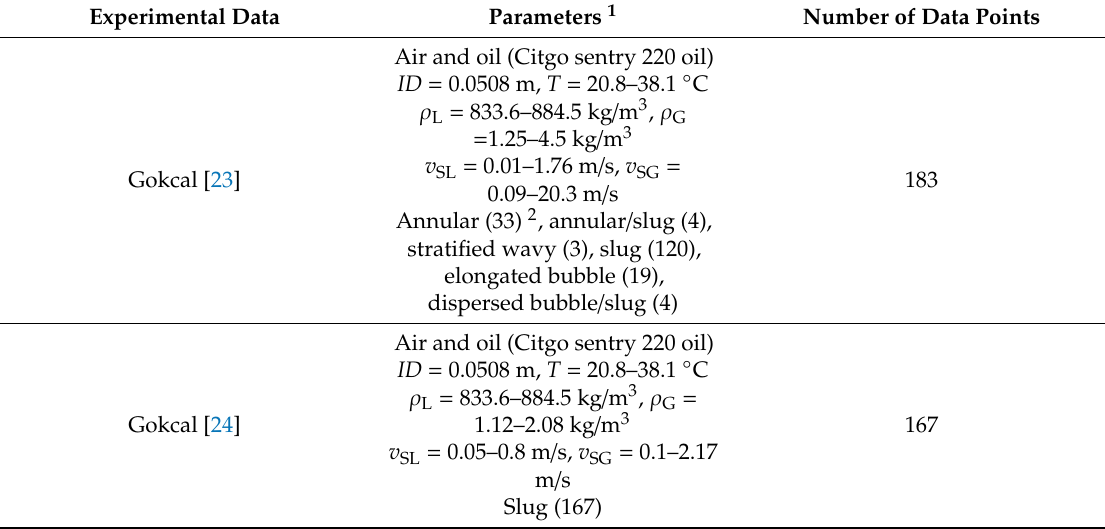
Table 1. Summary of experimental data for the input and the output parameters in the deep neural network (DNN).